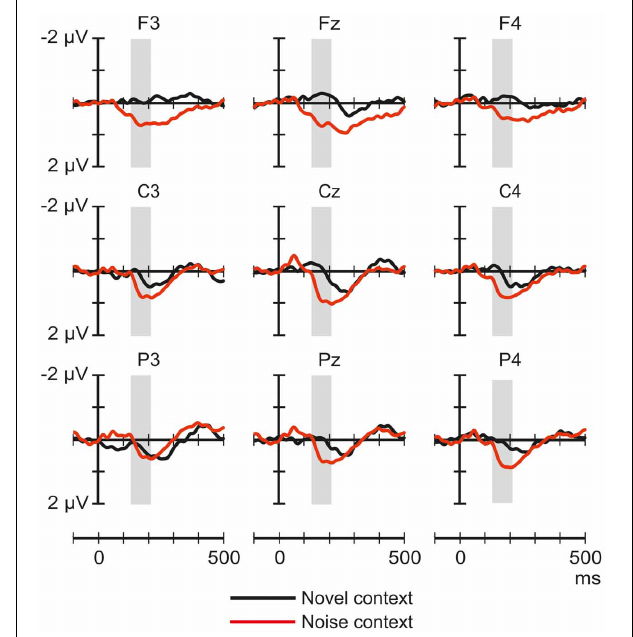
FIGURE 5 | Comparison between the group-averaged ERP responses elicited by the pure-tone deviants presented amongst frequent novel sounds (black line) and noise segments (red) at frontal, central, and parietal scalp locations. The amplitude measurement window is indicated by the gray